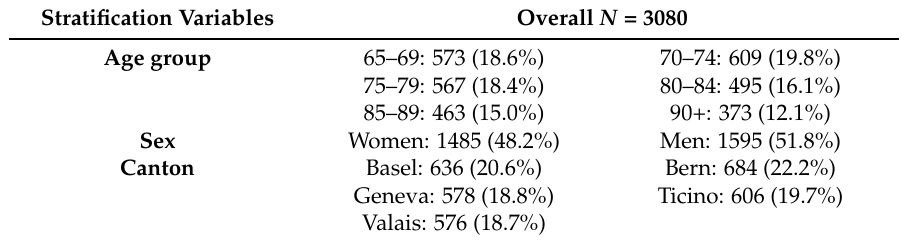
Table 1. Descriptive sample characteristics in terms of proportions regarding canton, sex, and age